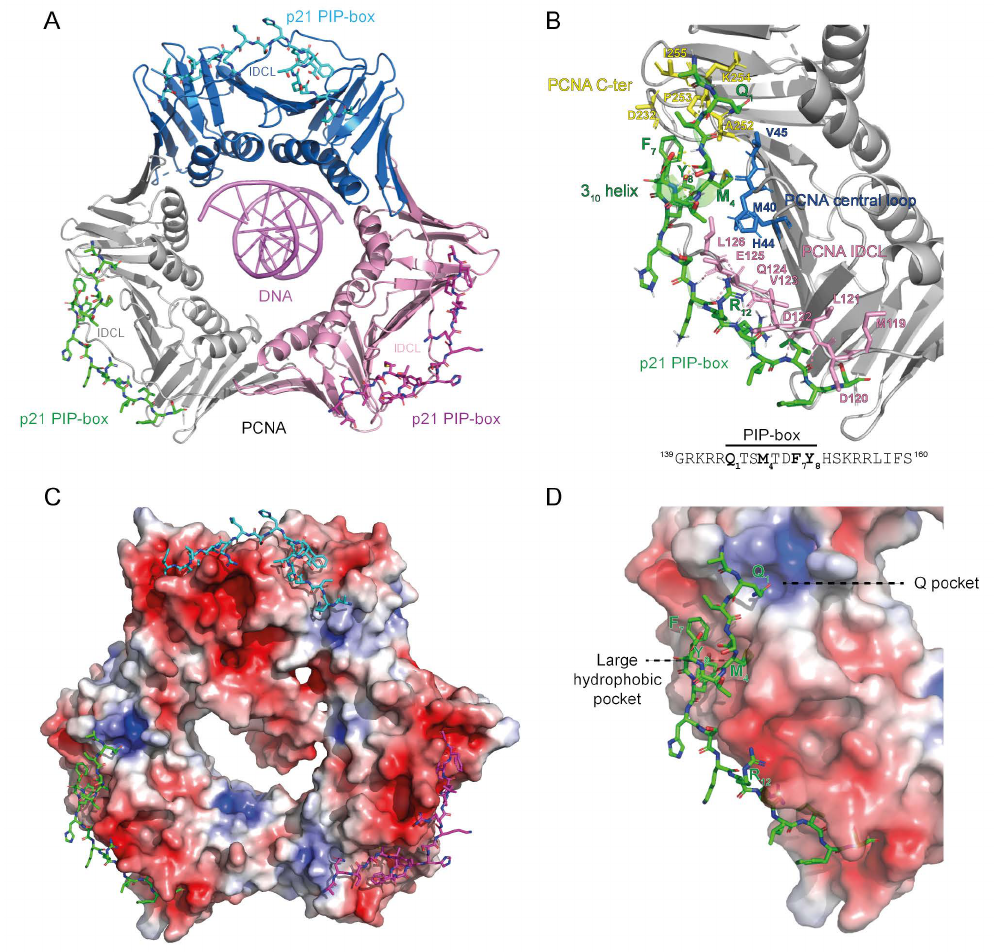
Figure 1. The structure of the proliferating cell nuclear antigen (PCNA) ring bound to DNA and the PIP-box of the CDK inhibitor p21. ( A ) Cartoon presentation of PCNA homotrimer bound to 10 bp dsDNA and p21 PIP-box peptide bound to the interdomain connector loop (IDCL) of each PCNA monomer. The image was obtained by overlaying PCNA-DNA co-structure (6GIS) [5] with PCNA-p21 PIP co-structure (1AXC) [31]. Three PCNA monomers are represented with different colors. ( B ) Interaction interface between PCNA and PIP-box shown for one PCNA monomer bound by one p21 PIP-box peptide. IDCL (pink), the central loop region (blue) and the C-terminal region (yellow) of PCNA anchor the PIP-box peptide through hydrophobic and electrostatic interactions. The sequence of the p21 PIP-box peptide is shown with the four critical residues indicated in bold. ( C,D ) Electron density distribution of PCNA from ( A , B ). The color-coded electrostatic surface potential of PCNA was drawn using the Adaptive Poisson-Boltzmann Solver package. The electrostatic potential ranges from 5 (red) to +5 (blue) kT/e. The images were generated using PyMOL [32]. −